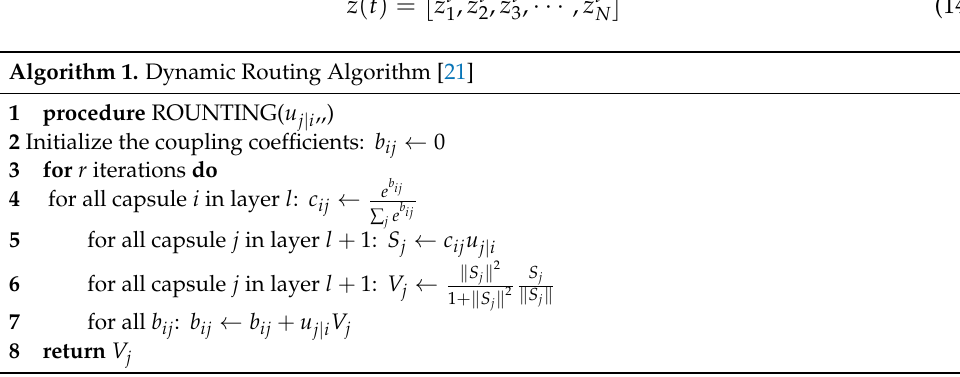
Algorithm 1. Dynamic Routing Algorithm